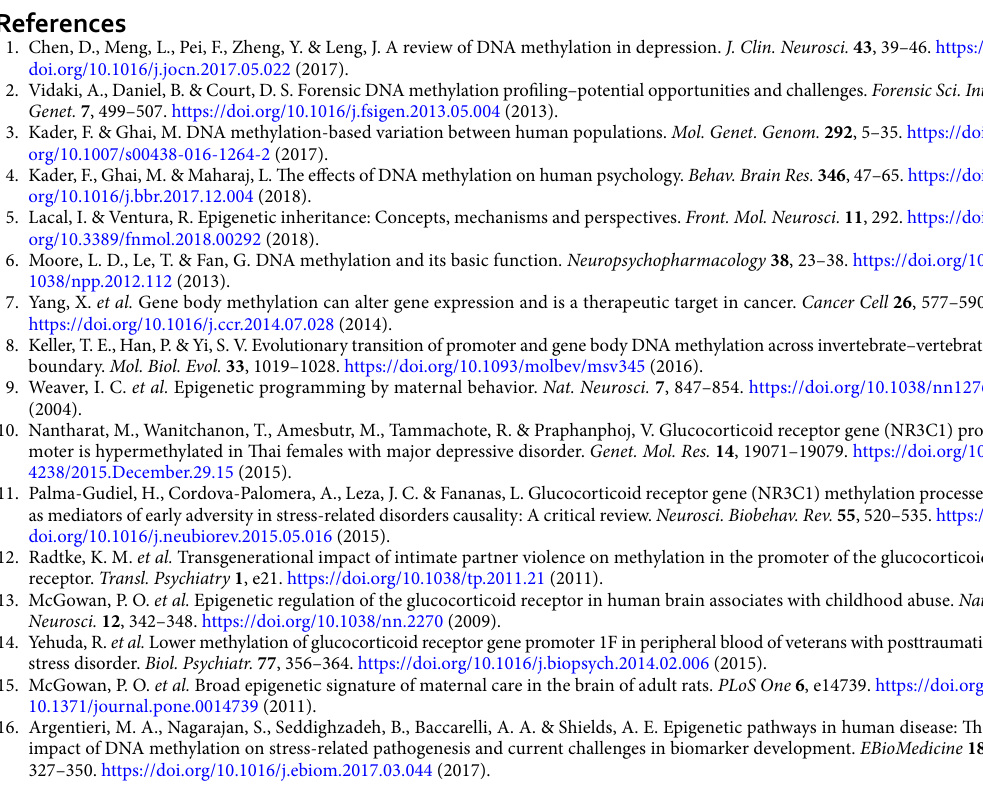
methylation by 33%. Chronic stress has previously been related to increased cortisol levels, leading to weight gain 61 . Excess weight is also related to chronic inflammation through NFκB pathways; however, no association between overweight and methylation status has been previously reported for the NR3C1 gene 62 . It is possible that hypomethylation of this region may be related to low-grade inflammation, a feature of the overweight state 63 . Although it was a cross-sectional study, and it is not possible to establish any causal relationships, this study is relevant as it revealed a direct or inverse association between methylation, alcohol consumption, overweight, and high cortisol levels related to NR3C1 non-methylation, whereas depression was related to methylation. Thus, we suggest that habits, lifestyle, and health status may influence NR3C1 gene regulation via methylation. Relationships involving genotype, environment, and phenotypic outcomes may be more refined than previously thought, depending on specific stressful events that can result in unique clinical consequences.